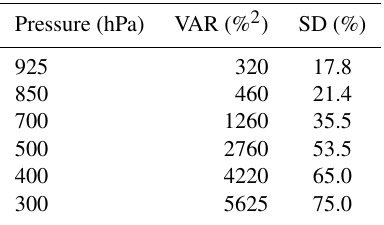
Table 1. Normalized differences of zonal mean RO and ERA spe- cific humidity in the tropics for cloudy conditions (computed from data in Vergados et al.,